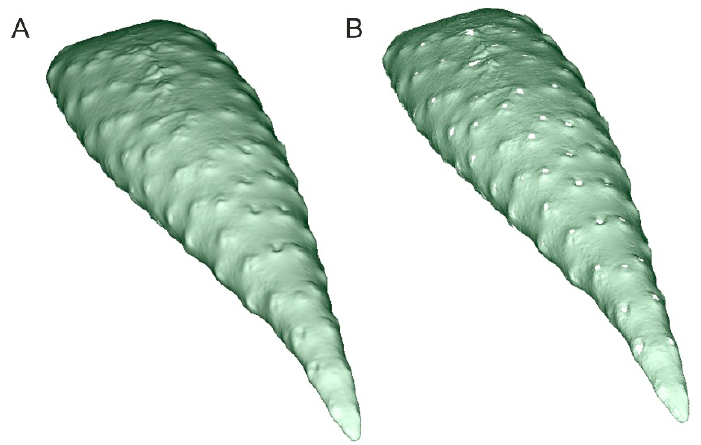
Figure 13. Fragment of an Aloe marlothii leaf with visible points where thorns grow: ( A ) Filled areas; ( B ) Holes in place of thorns.